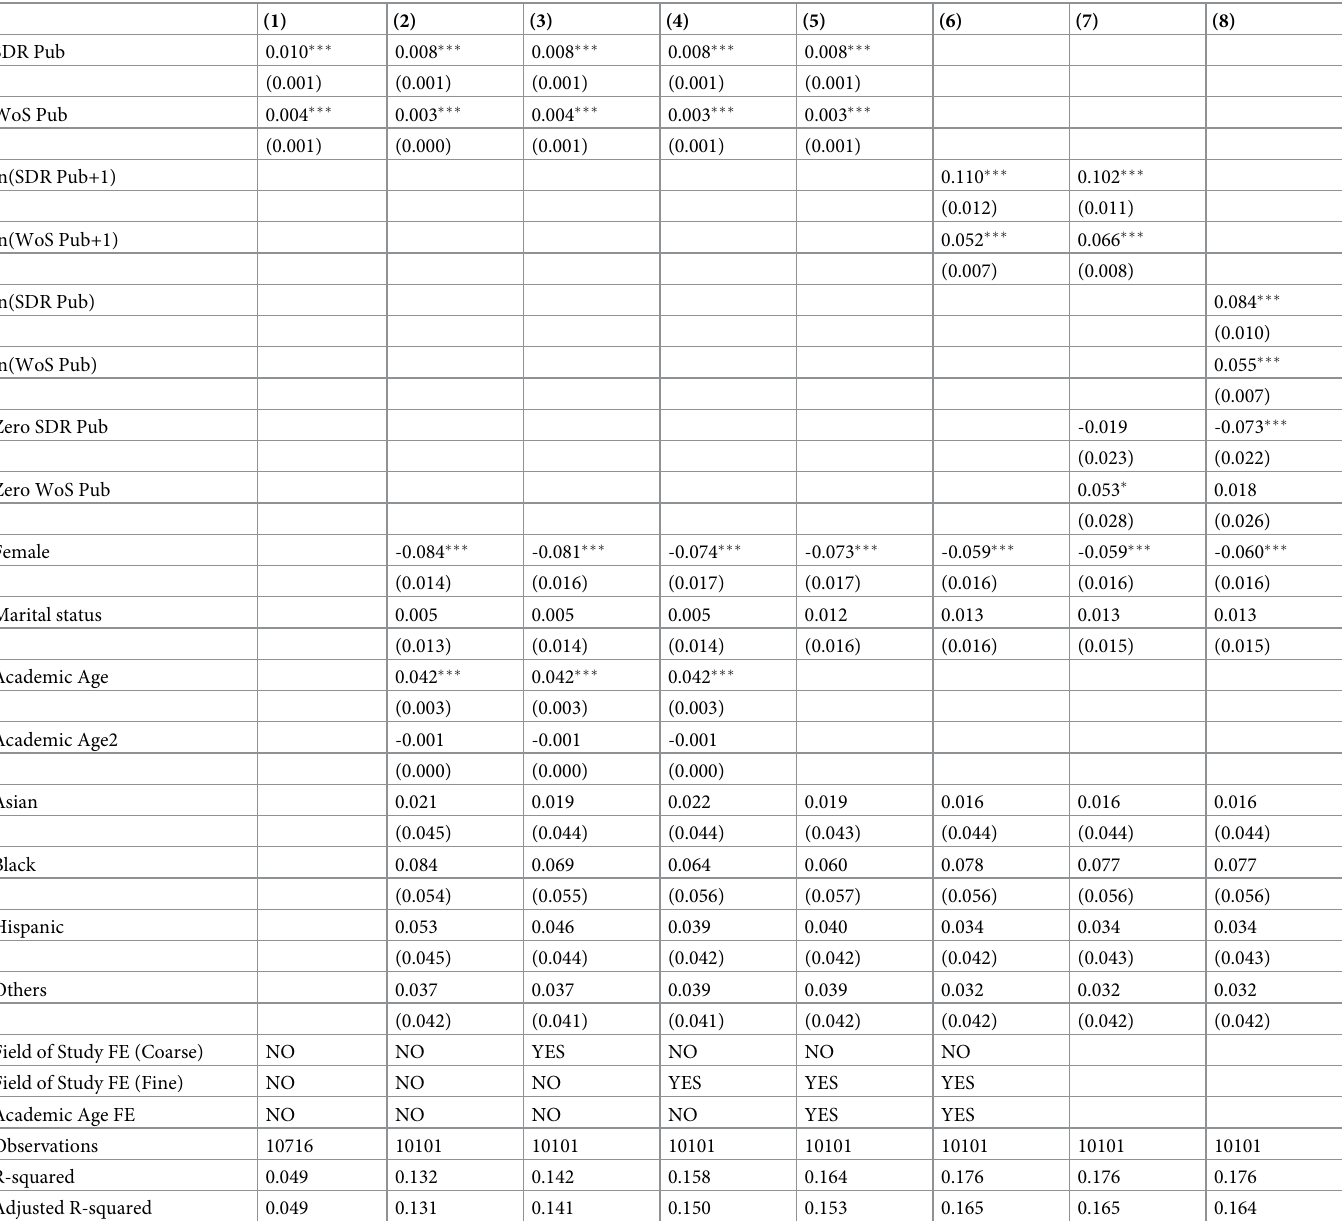
Table 2. Horse race comparisons of SDR and WoS publication counts as determinants of